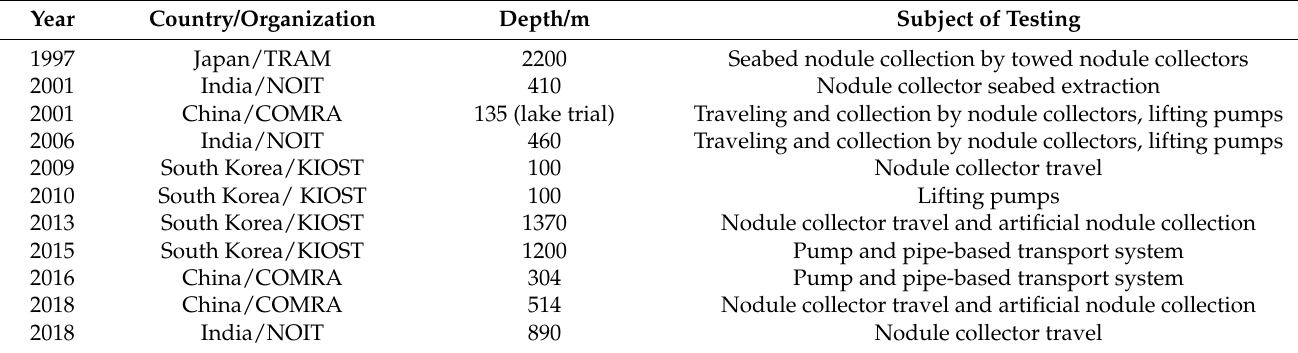
Table 1. Shallow-sea trials of key sub-systems conducted by pioneer investors in 1982–2018.